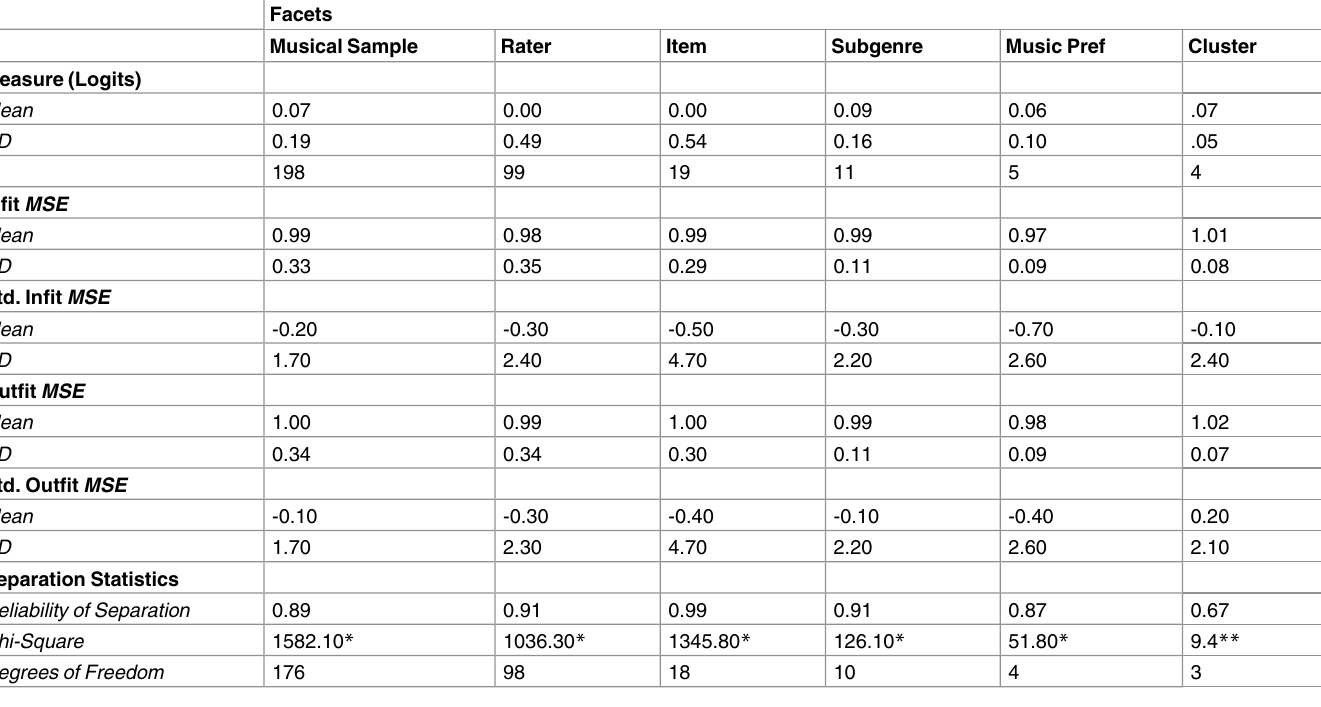
Table 3. Summary Statistics from the MFR-RS Model showing overall significance for all 6 facets (Musical Sample, Rater, Items, Subgenres, Musical Preference and Clusters derived from the Audio Analysis).